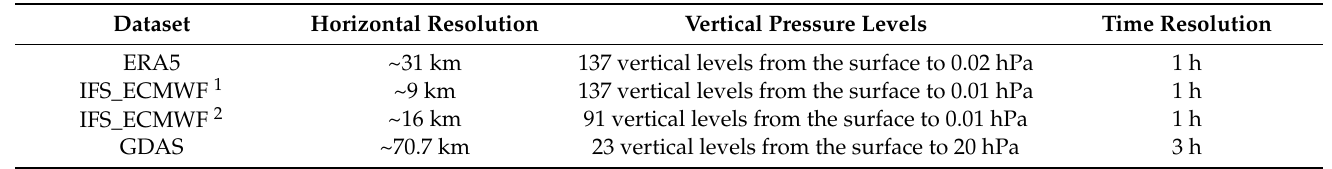
Table 2. Description of ERA5, ECMWF, and GDAS meteorology